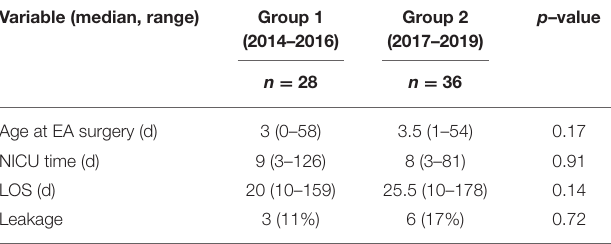
TABLE 3A | Surgical data of group 1 and group 2.